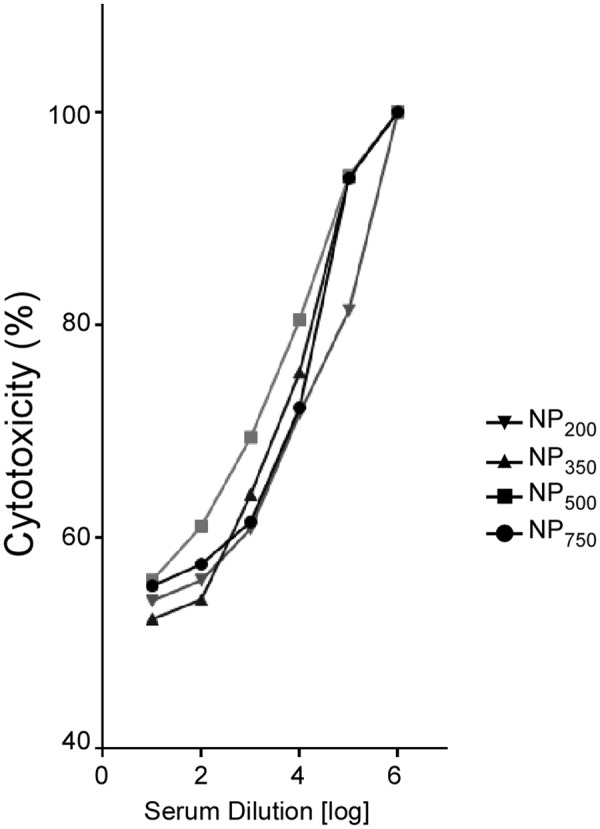
In vitro evaluation of antibody-mediated neutralization of TcdB. Serum samples from immunized mice (n = 5) were incubated with purified TcdB and then mixed with Vero cells. Cytotoxicity was assayed by lactate dehydrogenase (LDH) assay. No significant differences were detected between each immunized group. All data are representative of three independent experiments.